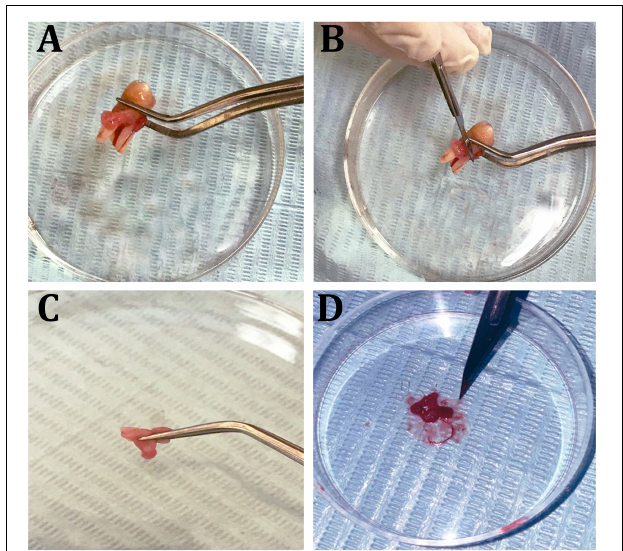
Figure 8 | Isolation steps of human periodontal ligament fibroblast cells (hPDLF). (A) Healthy molar tooth, (B) scraping periodontal layers, (C,D) mincing of the periodontal